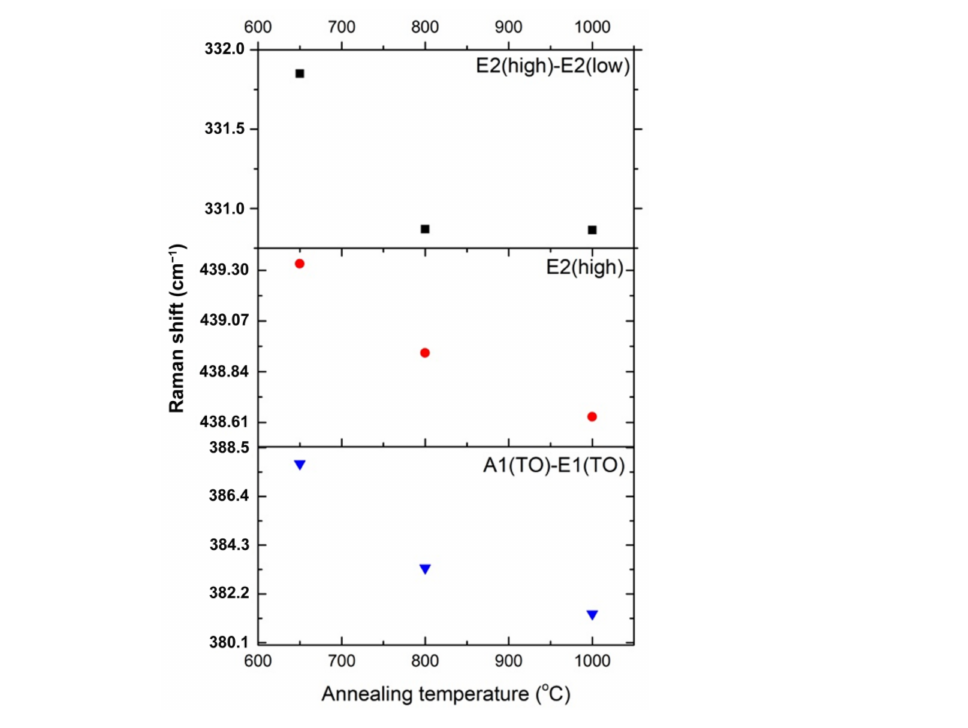
Figure 6. Raman shifting of the most prominent modes of ZnO films registered for different anneal- ing